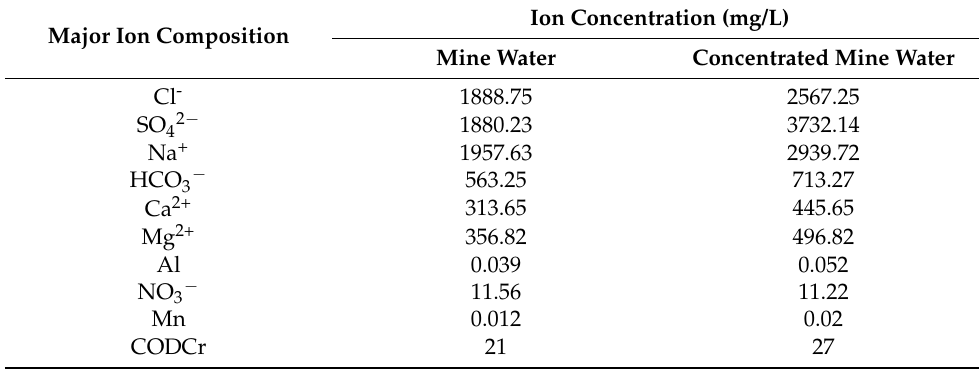
Table 3. The main composition of the mine water and reverse osmosis mine water. Table 2. Experimental water and water quality parameters. Major Ion